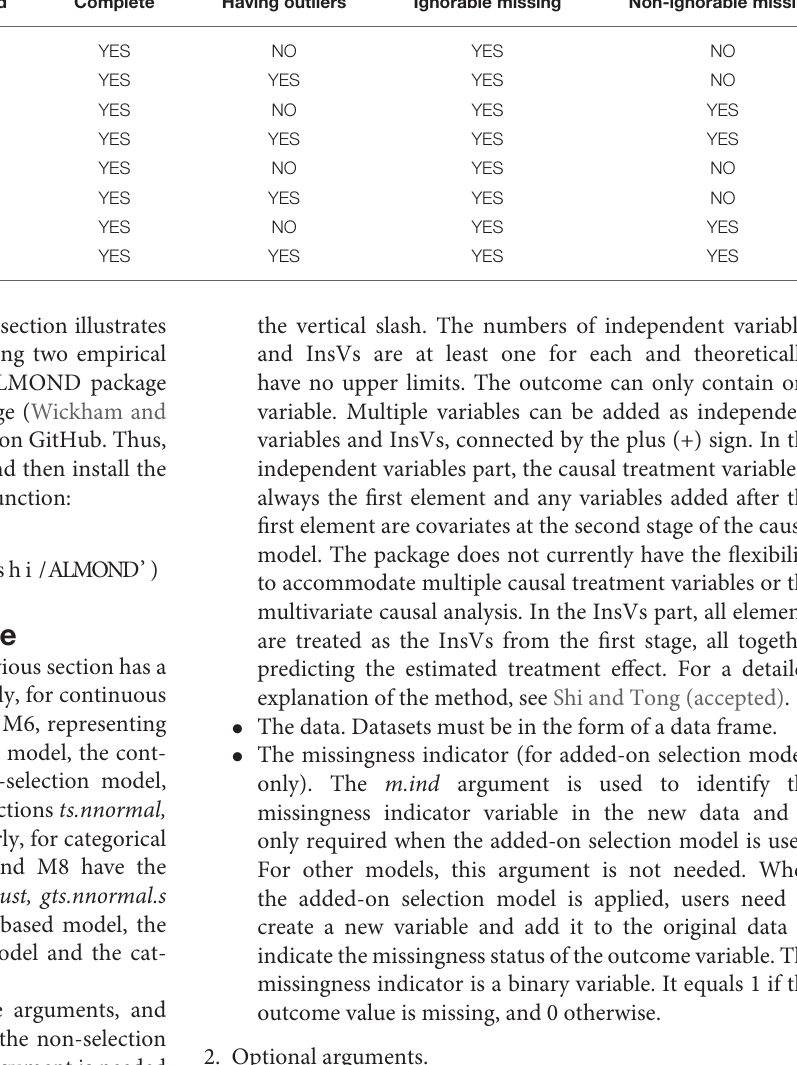
TABLE 1 | Taxonomy of models. Types of the model Types of outcome data Normally distributed Complete Having outliers Ignorable missing Cont-normal model Cont-robust